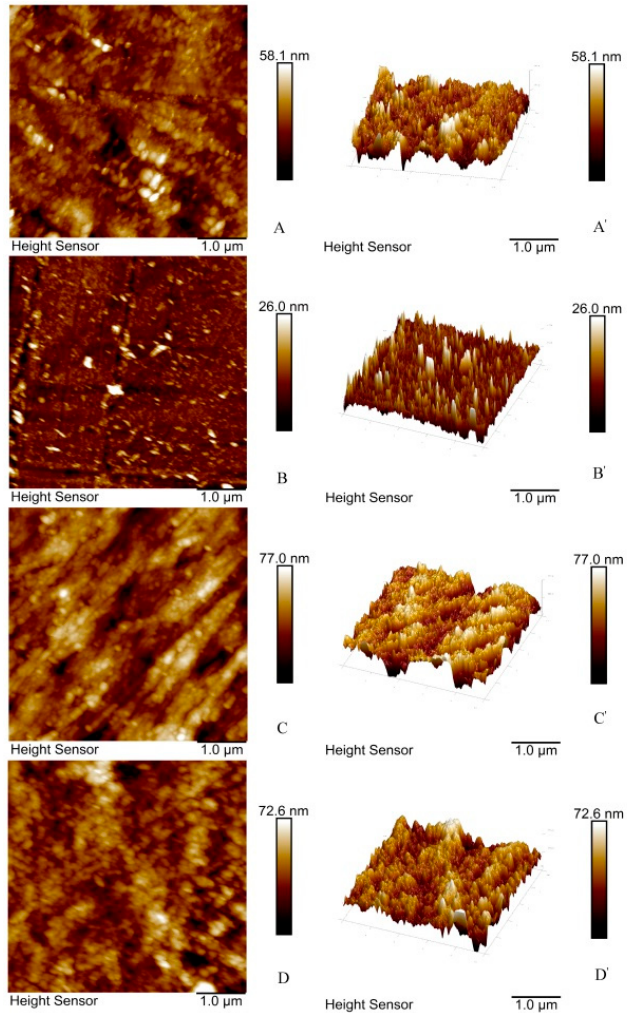
Figure 6. Atomic force microscopy (AFM)micrographs of regenerated MCC films from different regeneration baths: ( A ) methanol; ( B ) ethanol; ( C ) 5 wt % NaOH (aq.); ( D ) 5 wt % H 2 SO 4 (aq.).